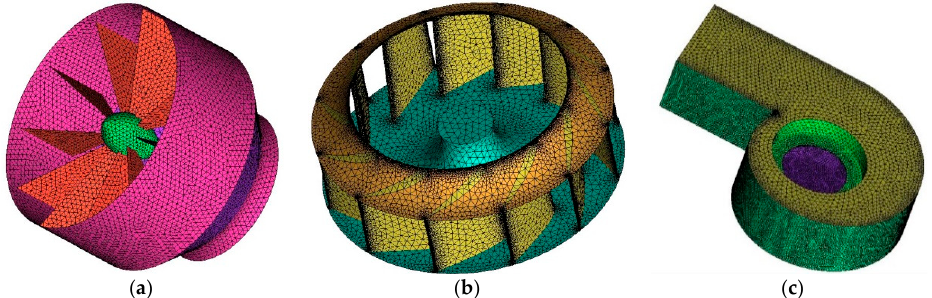
Figure 3. Computation grid of CF: ( a ) LB; ( b ) impeller; and ( c ) volute.